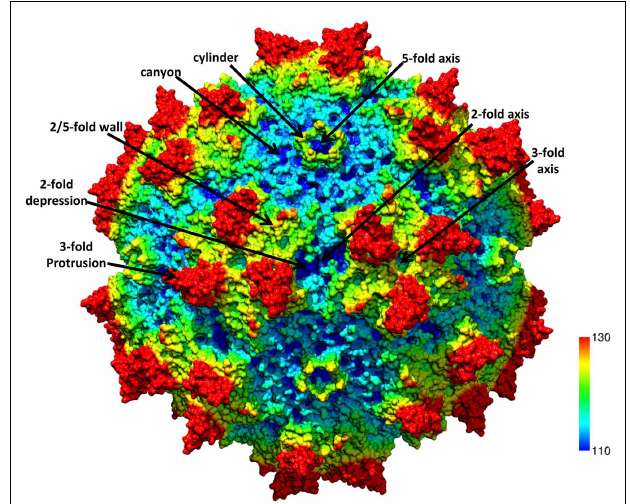
FIGURE 1 |TheAAV capsid . Radially color-cued (from capsid center to surface: blue-green-yellow-red; ~110–130Å) of the AAV1 capsid generated from 60VP monomers (RCSB PDB # 3NG9).The approximate icosahedral 2-, 3-, and 5-fold symmetry axes are as well as the AAV capsid surface features are indicated by the arrows and labeled.This image was generated using the Chimera program (40).